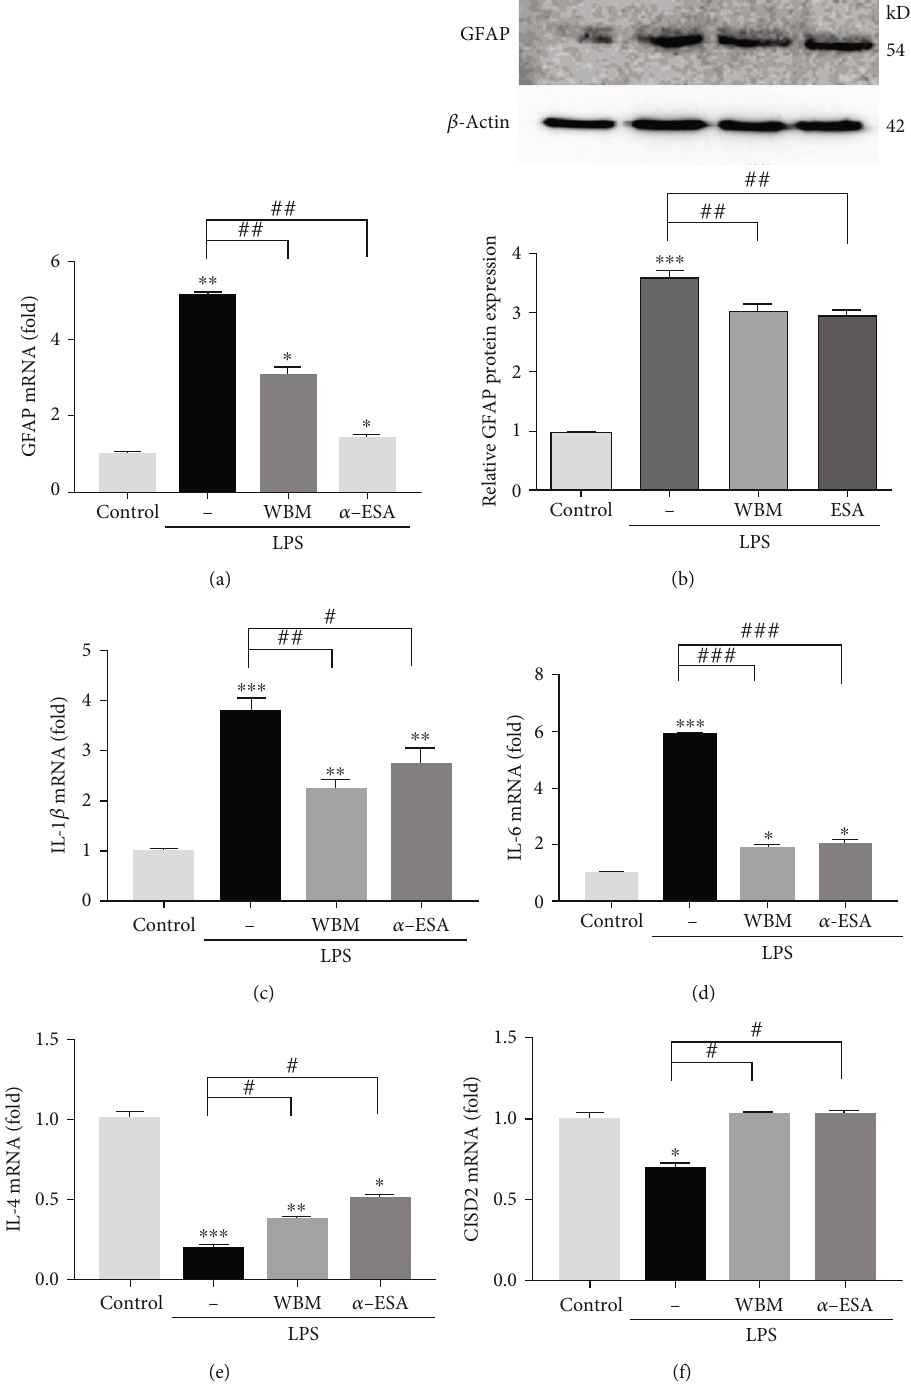
Figure 2: Injury-induced CISD2 downregulation, enhanced GFAP mRNA and protein expression, and proin fl ammation in LPS-challenged ALT astrocytes. WBM can prevent the abovementioned detrimental e ff ects. Results of mRNA expression of GFAP (a), GFAP protein (b), mRNA expression of IL-1 β (c), IL-6 (d), IL-4 (e), and CISD2 (f) in ALT cells with or without administration of WBM and α -ESA. Vertical bars indicate the mean ± standarderror of the mean (SEM) of mRNA expression ( n = 3 ). ∗ P < 0 : 05 vs. control, ∗∗ P < 0 : 01 vs. control, ∗∗∗ P < 0 : 001 vs. control, # P < 0 : 05 , ## P < 0 : 01 , and ### P < 0 : 001 indicate a signi fi cant di ff erence. Pair-wise multiple comparisons between groups were performed using the Newman-Keuls